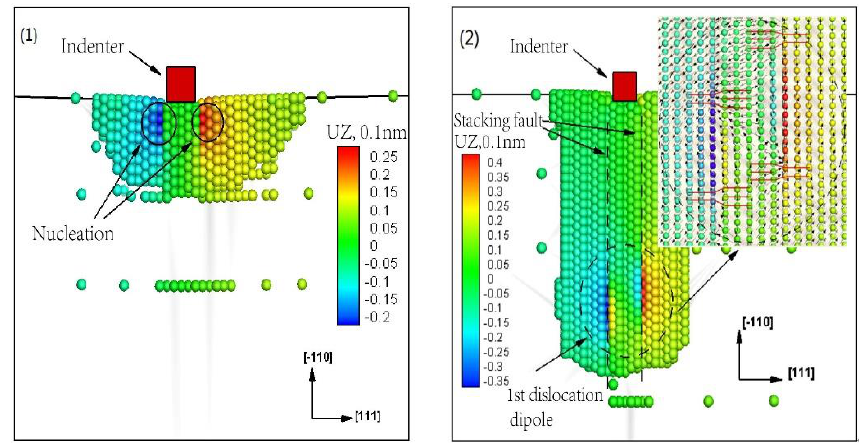
Figure 3. Snapshot of atoms under indenter and corresponding out-of-plane displacement plot, where UZ is atom displacement at out-of-plane. ( 1 ) point A in Figure 2 (dislocation nucleation); ( 2 ) point B in Figure 2 (dislocation emission).